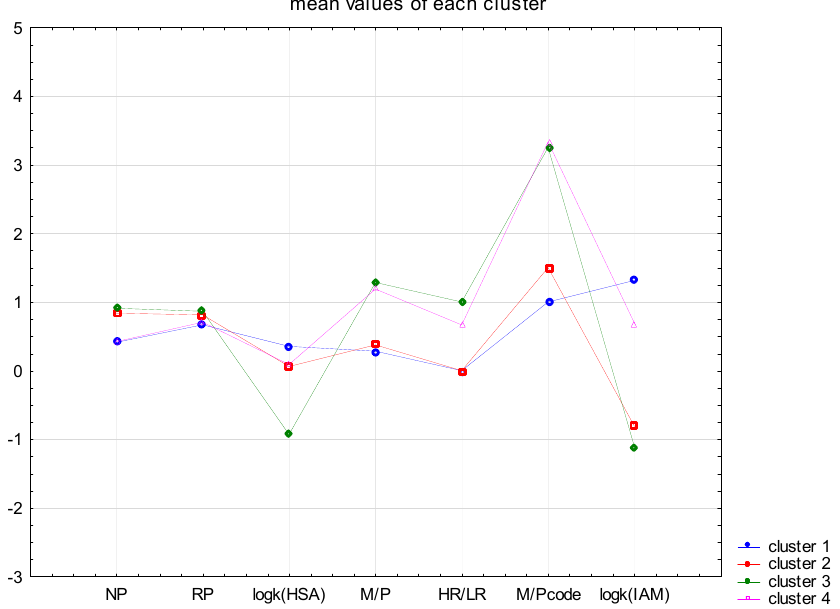
Figure 6. Graph of the mean values of the chromatographic data for four clusters of CNS+ drugs.